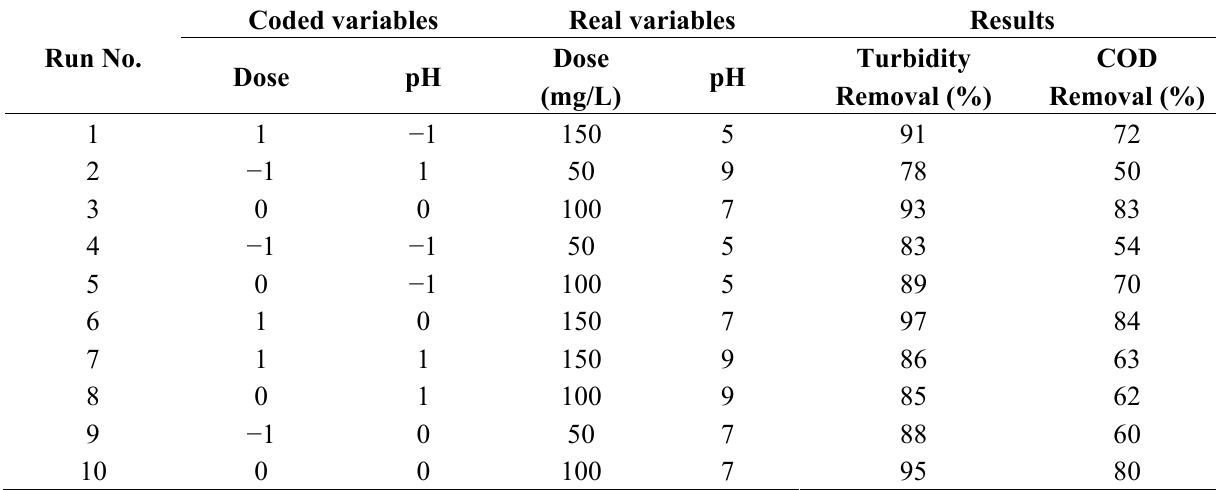
Table 2. Experimental variables and results for wastewater